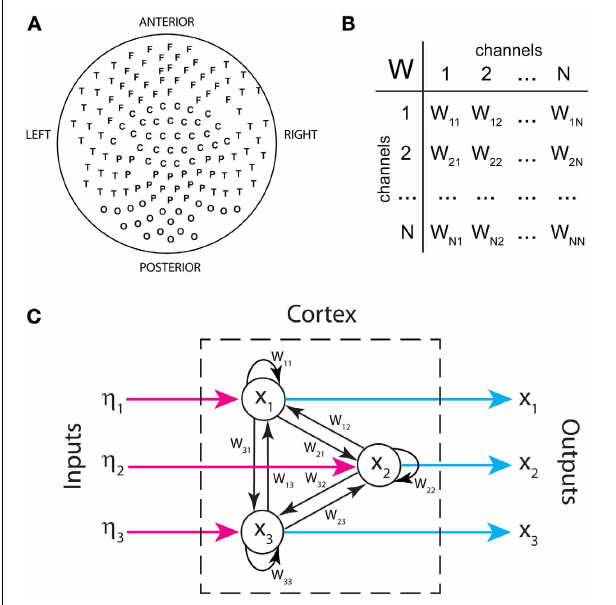
FIGURE 1 | Inputs and outputs of the cortical network as defined in our analysis. (A) Spatial arrangement of MEG sensors recording brain activity from the scalp (outputs). (B) Functional connectivity as a table of interactions between signals recorded by sensor pairs. (C) Schematic representation of the brain’s functional connectivity, its inputs and outputs. Only three nodes are